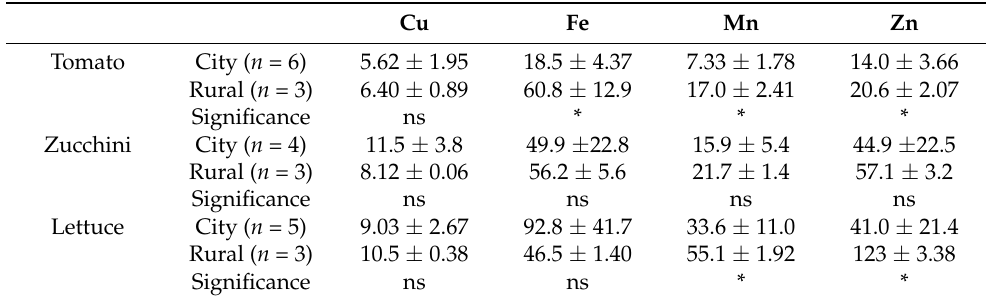
Table 3. Potential toxic element accumulation in tomato, zucchini, and lettuce cultivated in the City and Rural urban gardens. Values are mean ± standard deviation expressed as mg kg − 1 .